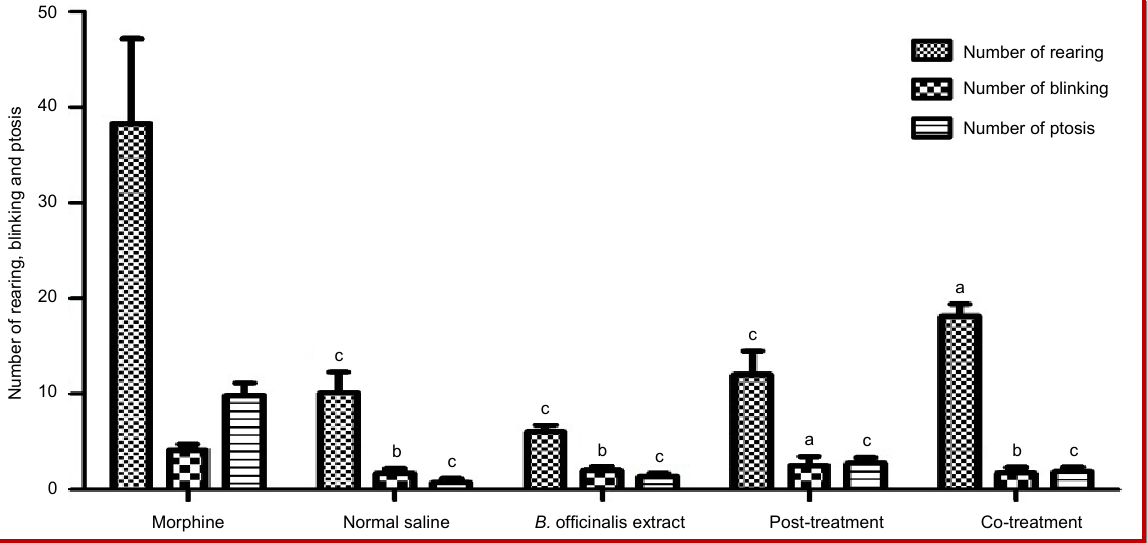
Figure 2: The effect of Borago officinalis extract injection, as post-treatment and co-treatment, on the frequency of naloxone-induced blinking, rearing and ptosis in morphine-dependent mice; a p<0.05; b p=0.01-0.05; c p<0.01